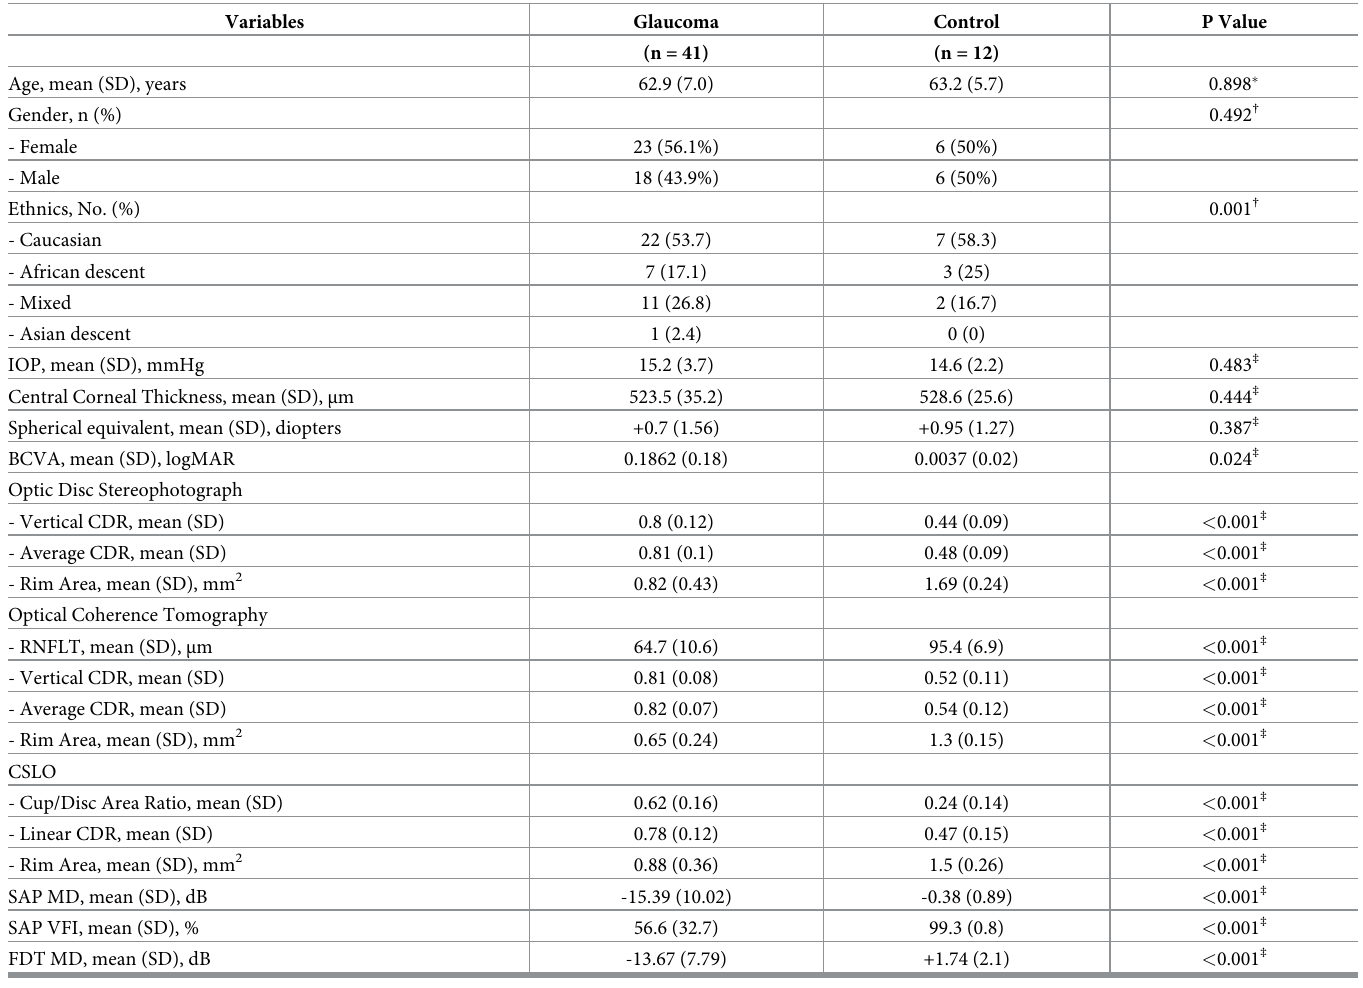
Table 1. Clinical and demographic characteristics of the study